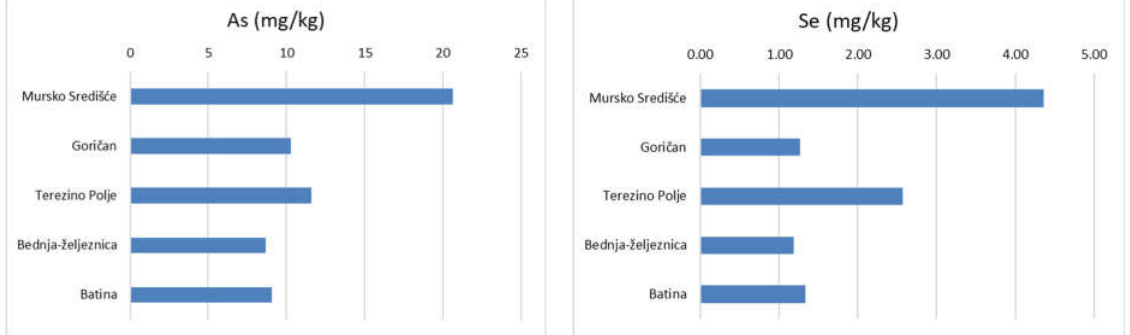
Figure 4. The average concentrations of Ca ( a ), Mg ( b ), Na ( c ), K ( d ), Fe ( e ), Al ( f ), As ( g ), and Se ( h ) in suspended sediments.